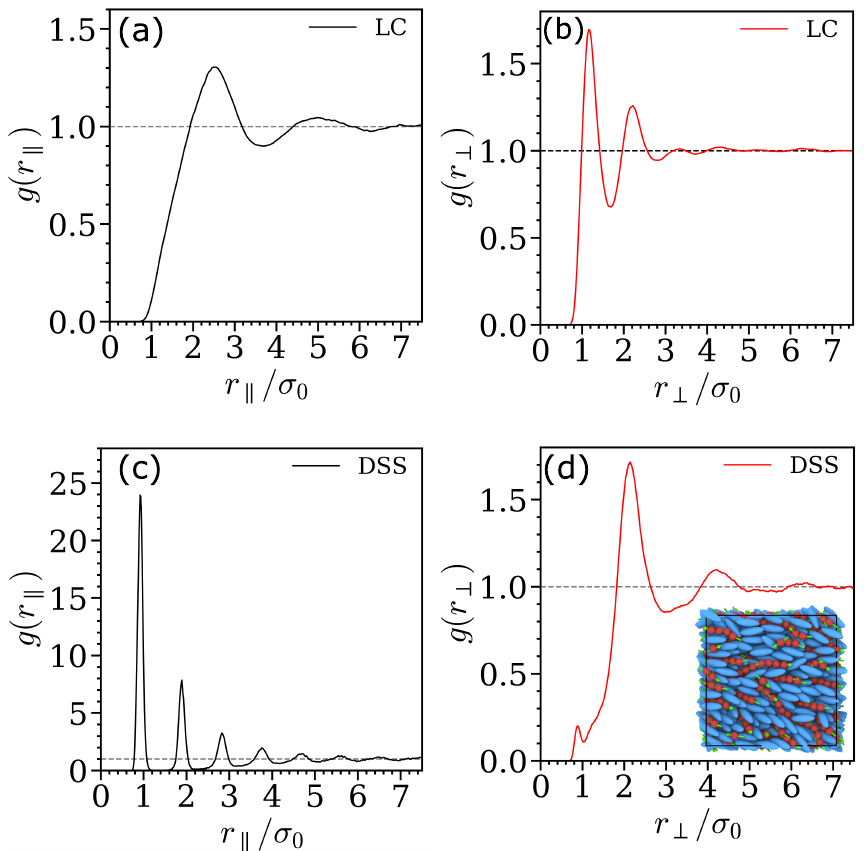
Figure 5. Projected pair correlation functions as a function of distance for the LC–DSS mixture at the density, ρ ∗ = 0.46: panel ( a ): projected pair correlation function for distances parallel to the director of LCs, g ( r (cid:107) ) , as a function of distance; panel ( b ): the pair correlation function for distances perpendicular to the director of the LCs, g ( r ⊥ ) , as a function of distance; panel ( c , d ): components of the pair correlation functions parallel and perpendicular to the director of the DSS as a function of distance. The grey dashed line represents the value of g ( r ) equal to 1. The inset in panel ( d ) represents the front of the snapshot shown in Figure